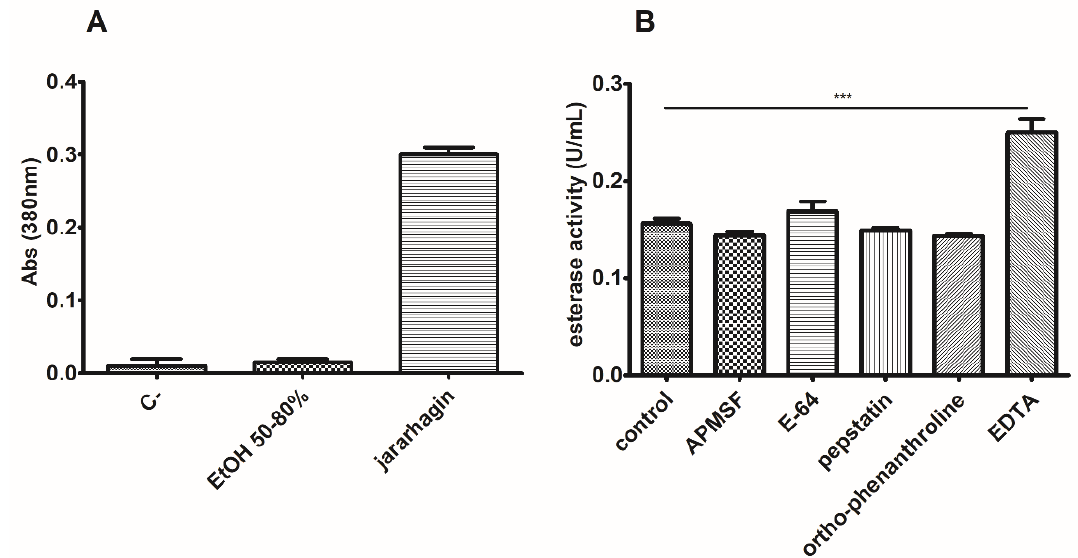
Figure 10. Esterase activity is not due to proteolytic activity. The azocasein assay ( A ) could not detect significant peptidase activity in the EtOH 50–80% fraction. ( B ) Enzymatic analysis in the presence of different peptidase inhibitors corroborated the former finding. Noticeably, the esterase activity of this fraction was enhanced by EDTA addition. *** p < 0.001.